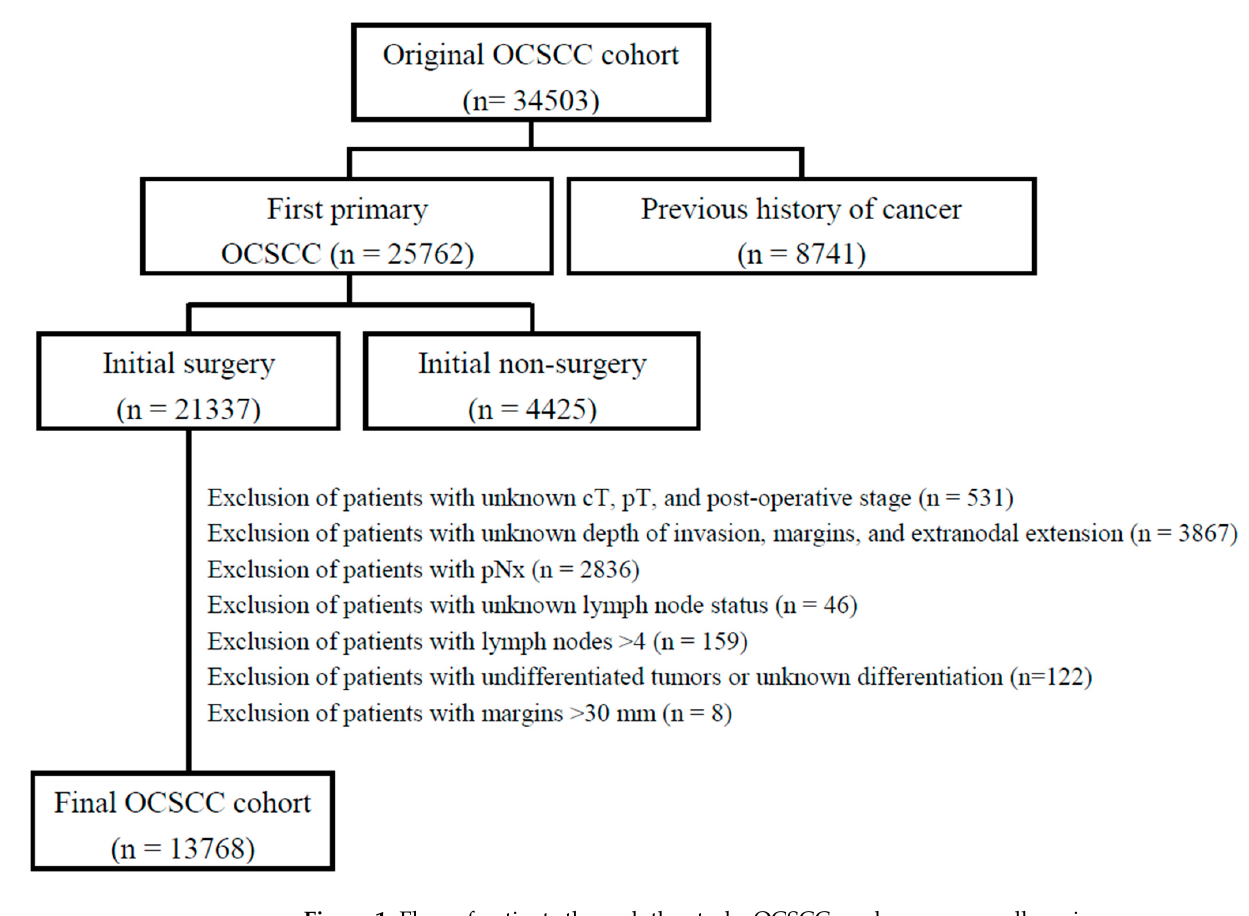
Figure 1. Flow of patients through the study. OCSCC, oral squamous cell